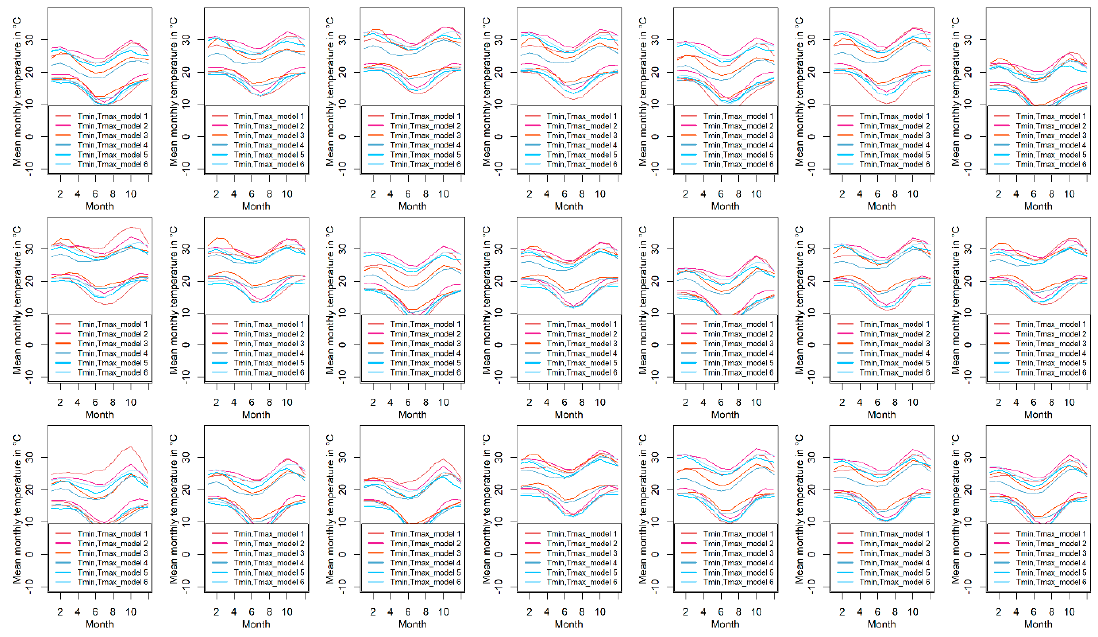
Figure A1. Temperature from 1979–2005 for the 21 utilized CORDEX Africa datagrids before bias-correction. Each graph shows the average monthly temperature for all six models introduced in Table 2. Tmin and Tmax represent the mean monthly minimum and maximum temperatures respectively.